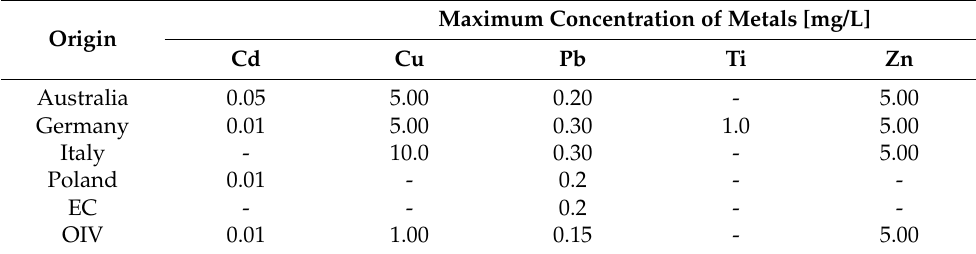
Table 1. The maximum admissible concentration of selected elements established by some countries in reference to standards given by the OIV